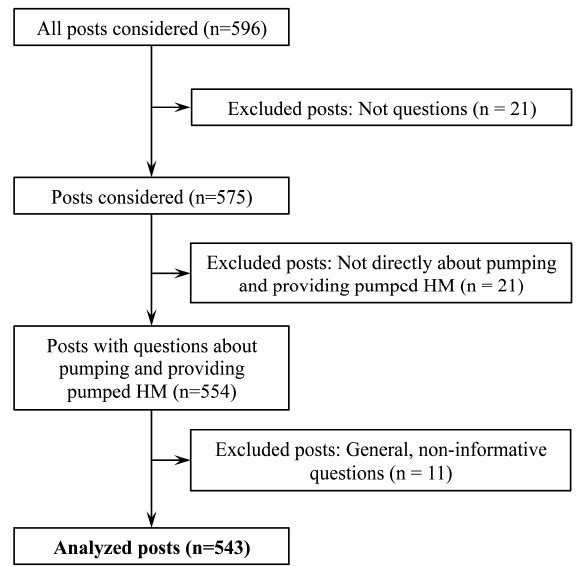
Figure 1. Inclusion flowchart of data for analyses. This figure shows the process to determine which posts, among the 596 posts screened, were included into the final analyses.